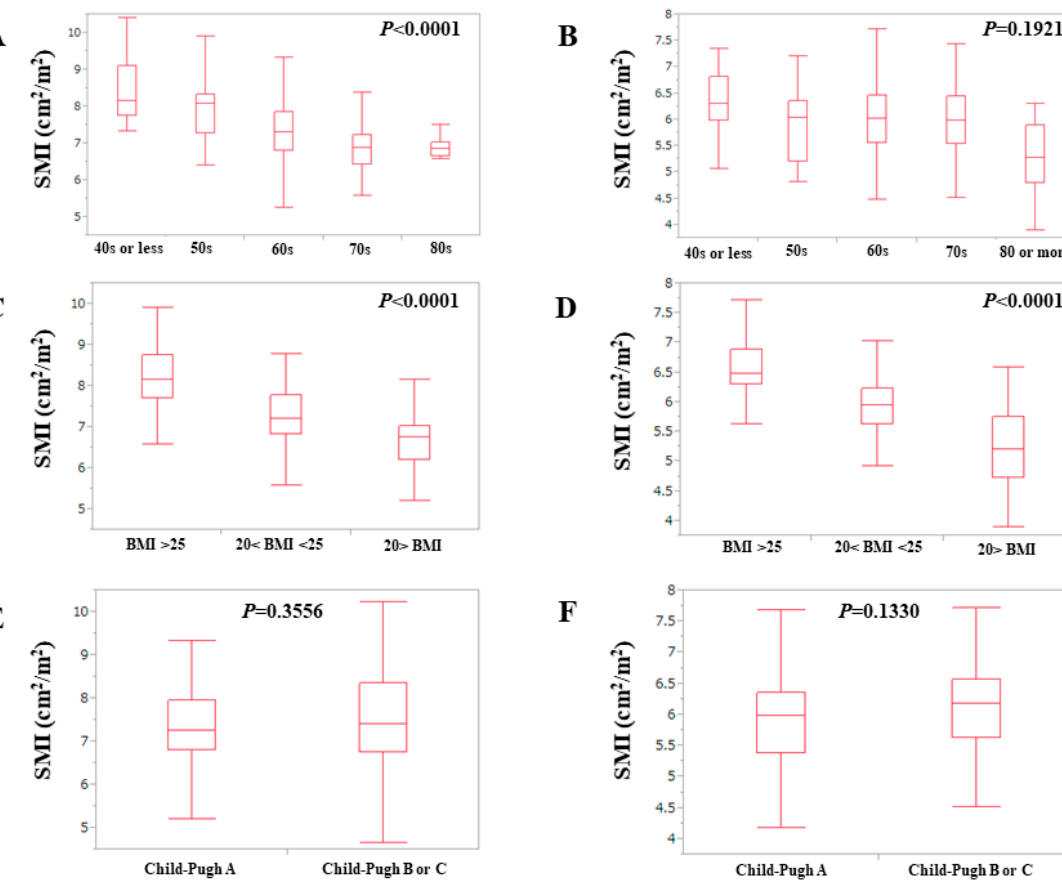
Figure 1. ( A , B ) Relationship between SMI and age in males ( A ) and females ( B ). ( C , D ) Relationship between SMI and BMI in males ( C ) and females ( D ). ( E , F ) Relationship between SMI and Child-Pugh classification in males ( E ) and females ( F ). SMI: skeletal muscle mass index; BMI: body mass index.